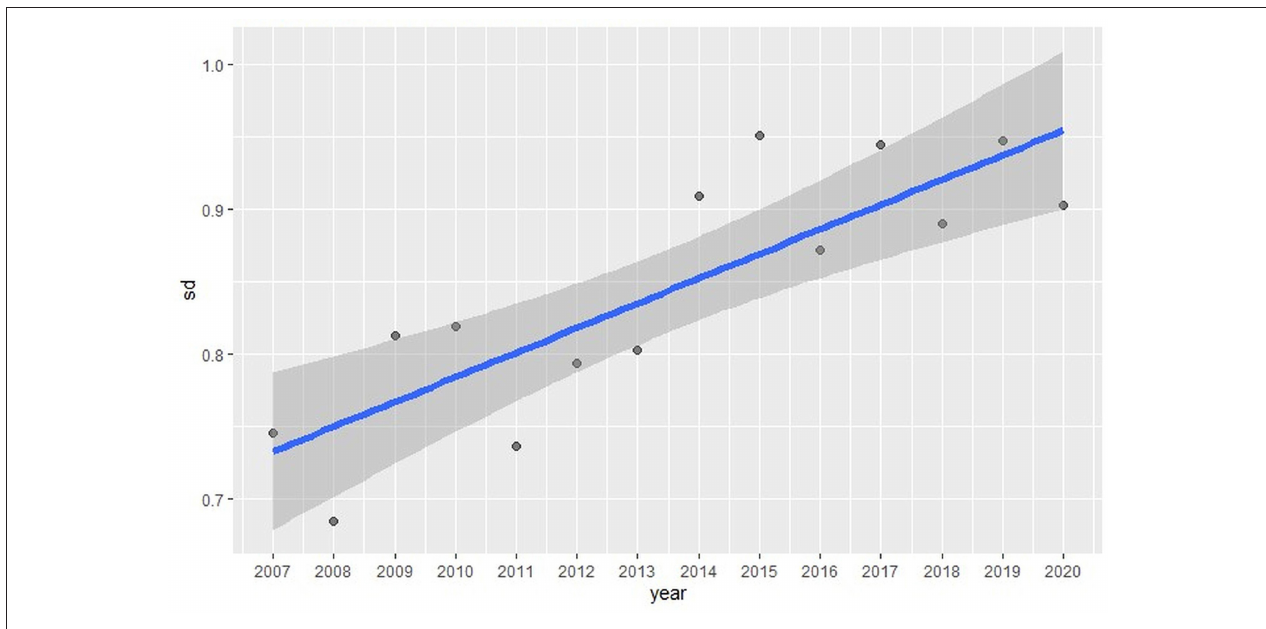
FIGURE 5 | Standard deviations over